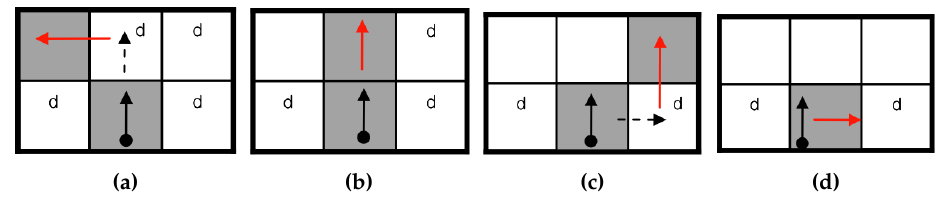
Figure 6. Contour-following sequence of the Theo Pavlidis algorithm (TPA) [16]. ( a ) Front-left contour; ( b ) front contour; ( c ) front-right contour; ( d ) rotation.